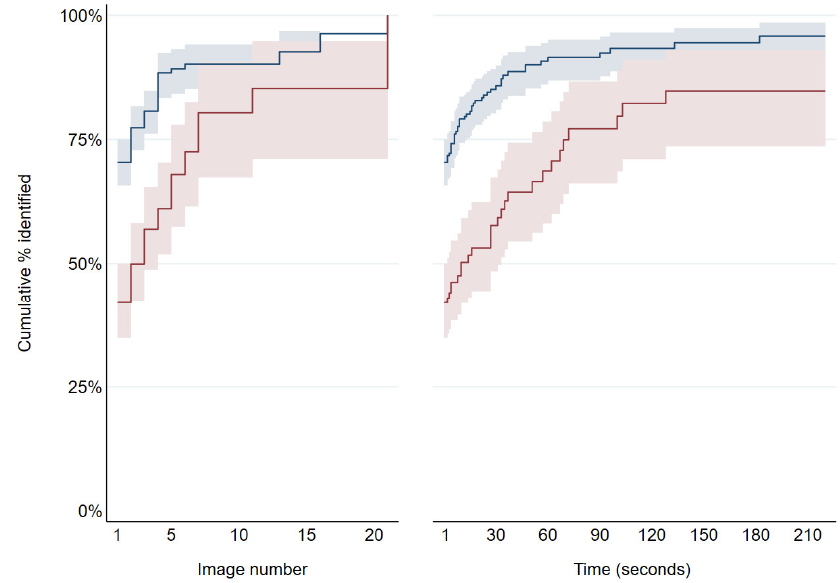
Figure 7. Cumulative percentages of observation events where the horse was identified by number of images (left-hand graph) and time from start of each observation event (right-hand graph) from still image observation events in the daytime (blue) and night-time (red). Kaplan–Meier failure functions are graphed; these are equivalent to cumulative percentages of observation events where each horse had been identified by the specified x -axis if no observation events had been right-censored. Shaded areas are point-wise 95% confidence intervals.